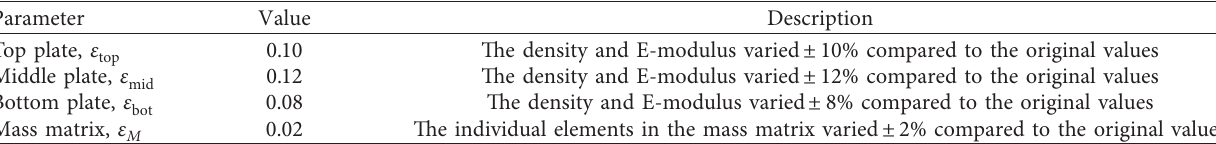
Table 1: List of chosen parameters to perturb the reference model in the simulations. Parameter Value Description 0.10 Top plate, ε top 0.12 Middle plate, ε mid Bottom plate, ε bot